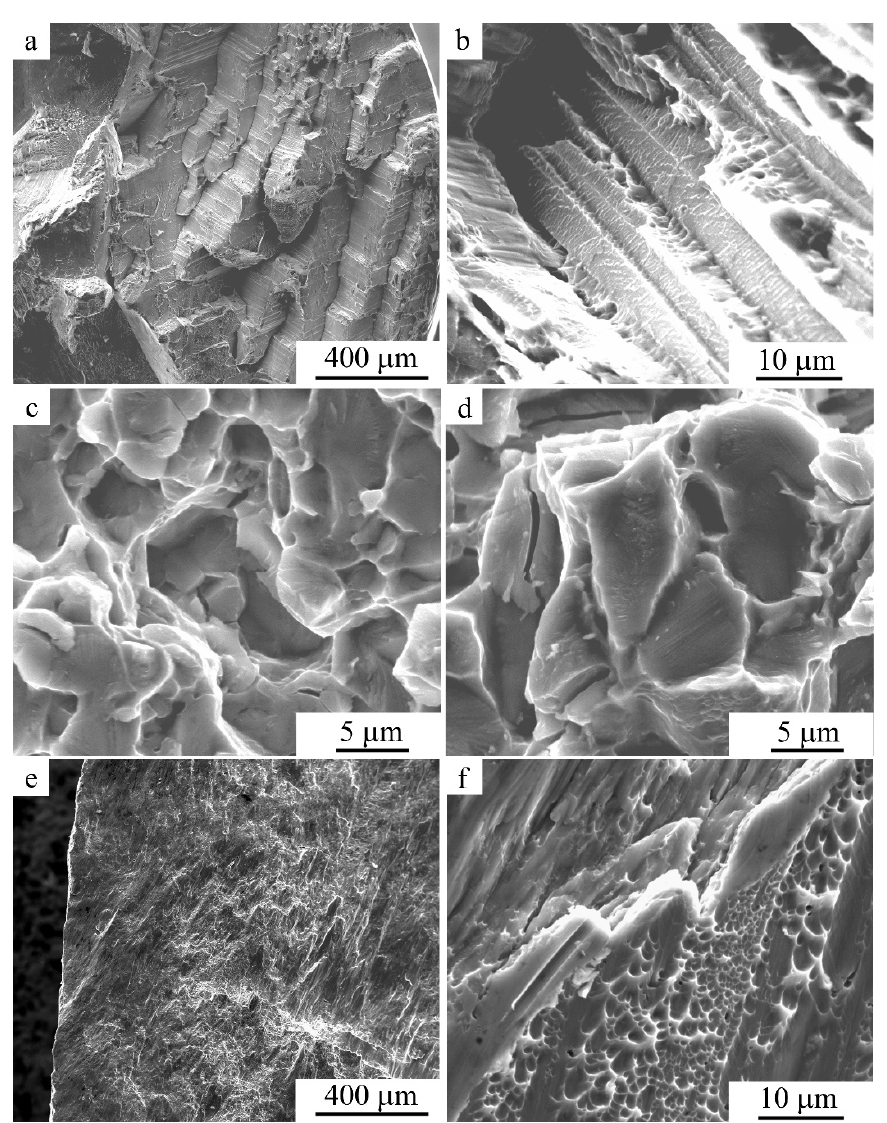
Figure 4. Secondary electron SEM images of the fracture surfaces in the Cu-14Al-4Ni alloy after ( a – d ) tensile tests or ( e , f ) compression tests. ( a – d ) tensile tests or ( e , f ) compression